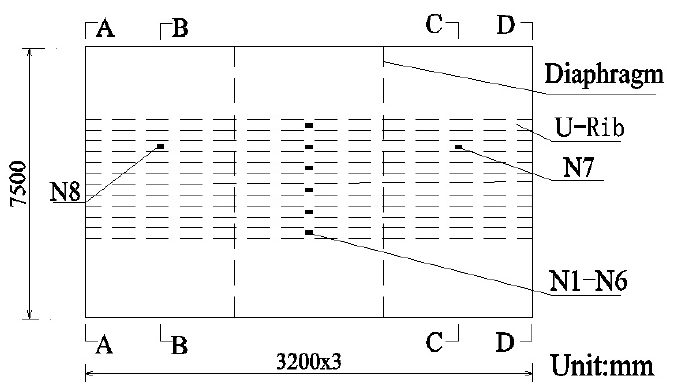
Figure 2. The segmental model of an orthotropic bridge deck and layout of the measurement points.